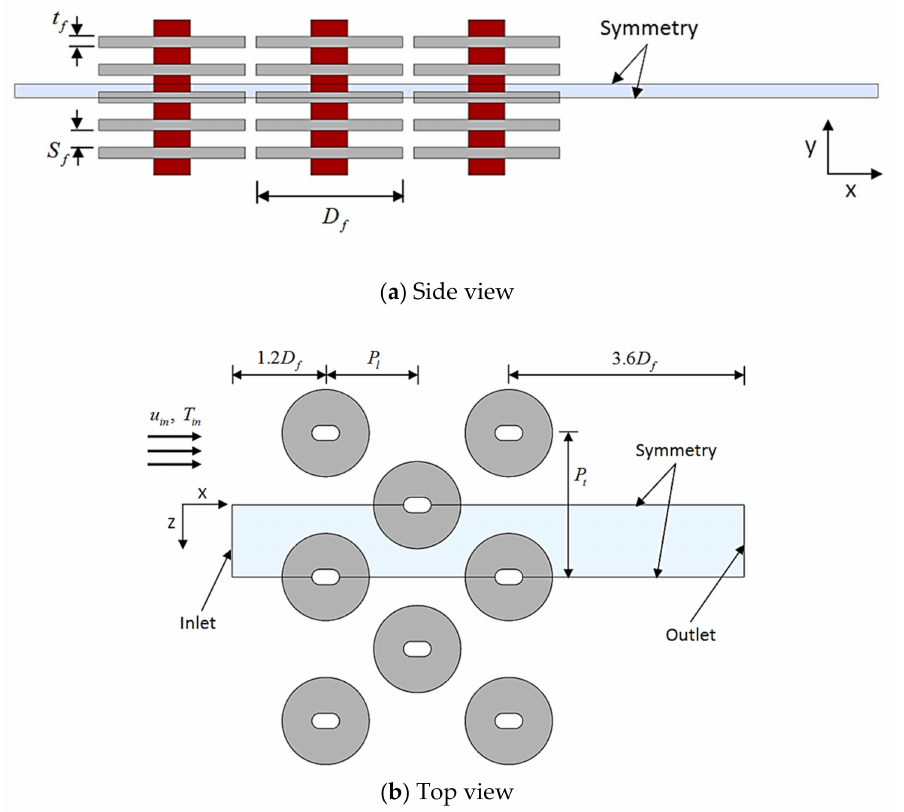
Figure 1. Scheme representing the geometrical parameters of the investigated annular fins with a flat tube.